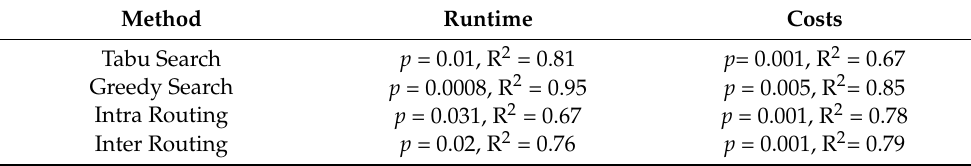
Table 8. Performance comparison of PSO algorithm with other